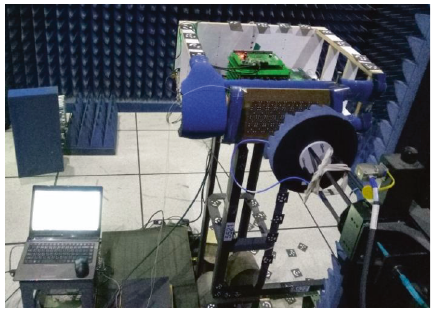
Figure 14: Active skin antenna prototype.